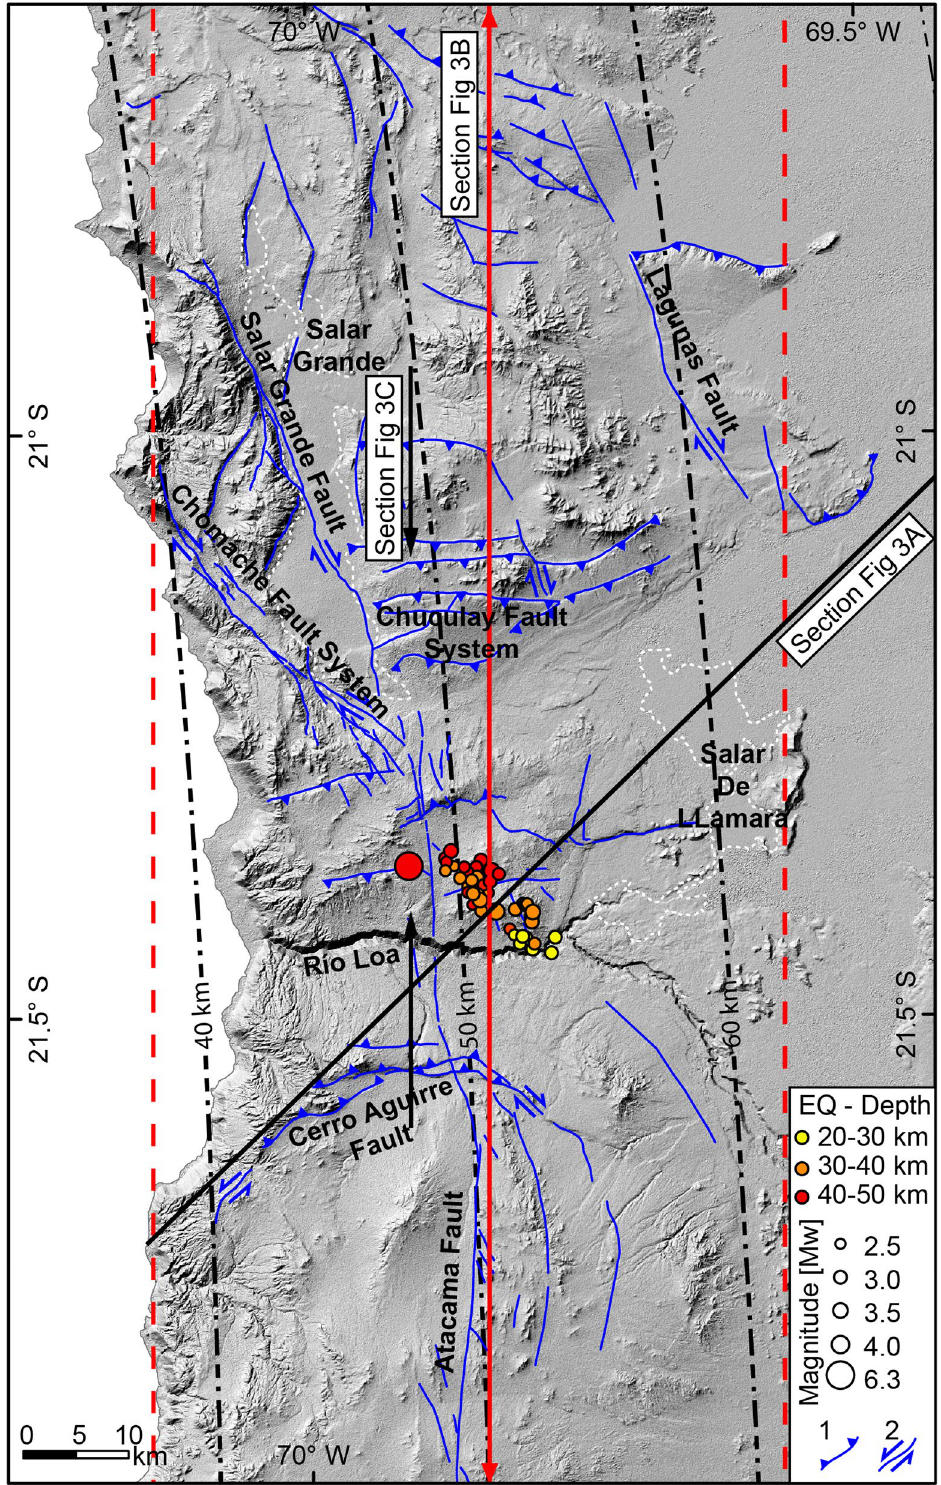
Figure 2. Main upper plate faults of the Coastal Cordillera of northern Chile. Grey background is a hillshade image generated by ArcGIS 10.8.2 (https:// www. esri. cl/ es- cl/ inicio) based on the 30-m DEM provided by open-access ALOS PALSAR data (https:// search. asf. alaska. edu/#/). The circles represent the HypoDD-relocated hypocentre of the aftershock sequence of the M w 6.3, the diameter is scaled to the moment magnitude, and the colour scale represents the focal depths. The black lines with arrows represent the profile in Fig. 3C, and dashed vertical red lines represent the border of the swath profile containing the hypocentre locations of Sippl et al. 7